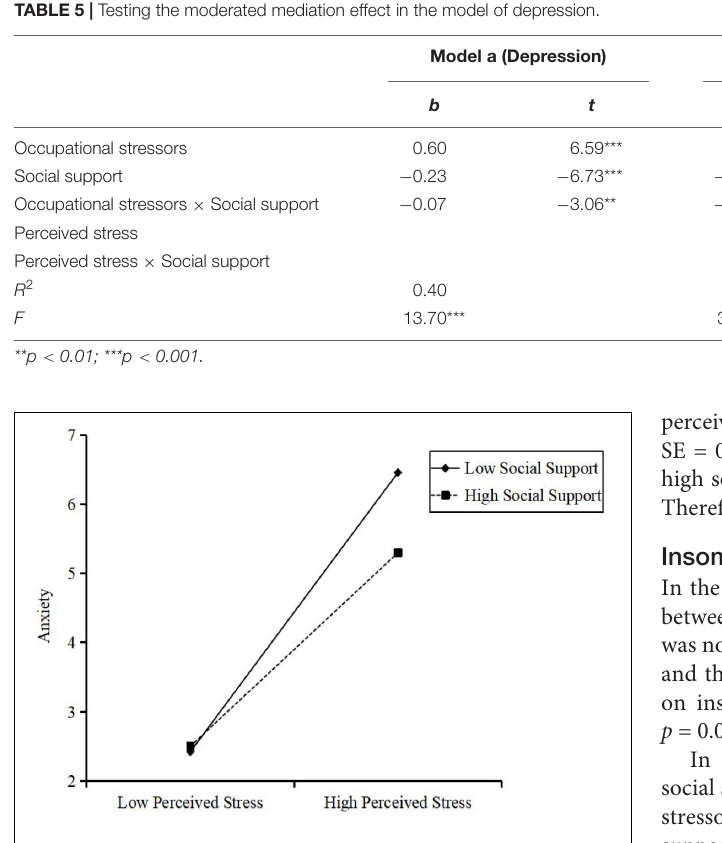
FIGURE 3 | Interaction effect of social support and perceived stress on the anxiety symptom. High and low levels of perceived stress and social support represent one standard deviation above and below the mean,